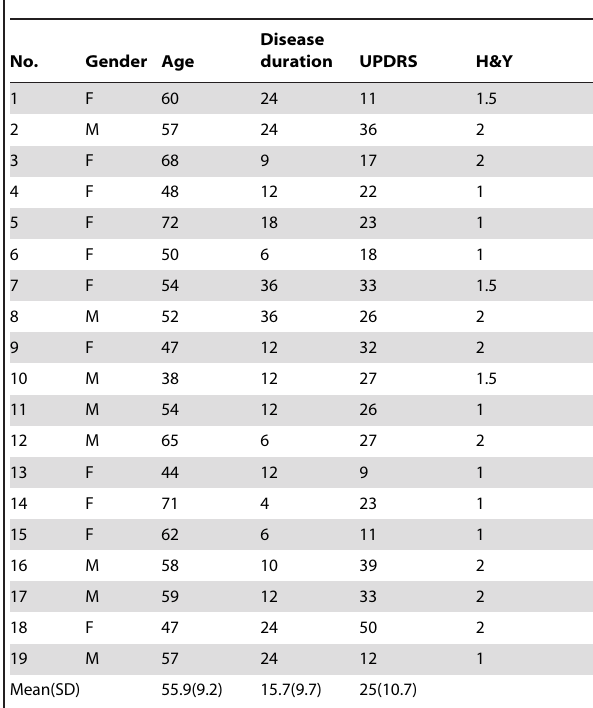
Abbreviations: UPDRS, Unified Parkinson’s disease Rating Scale; H&Y, Hoehn and Yahr Scale; M, male; F, female.